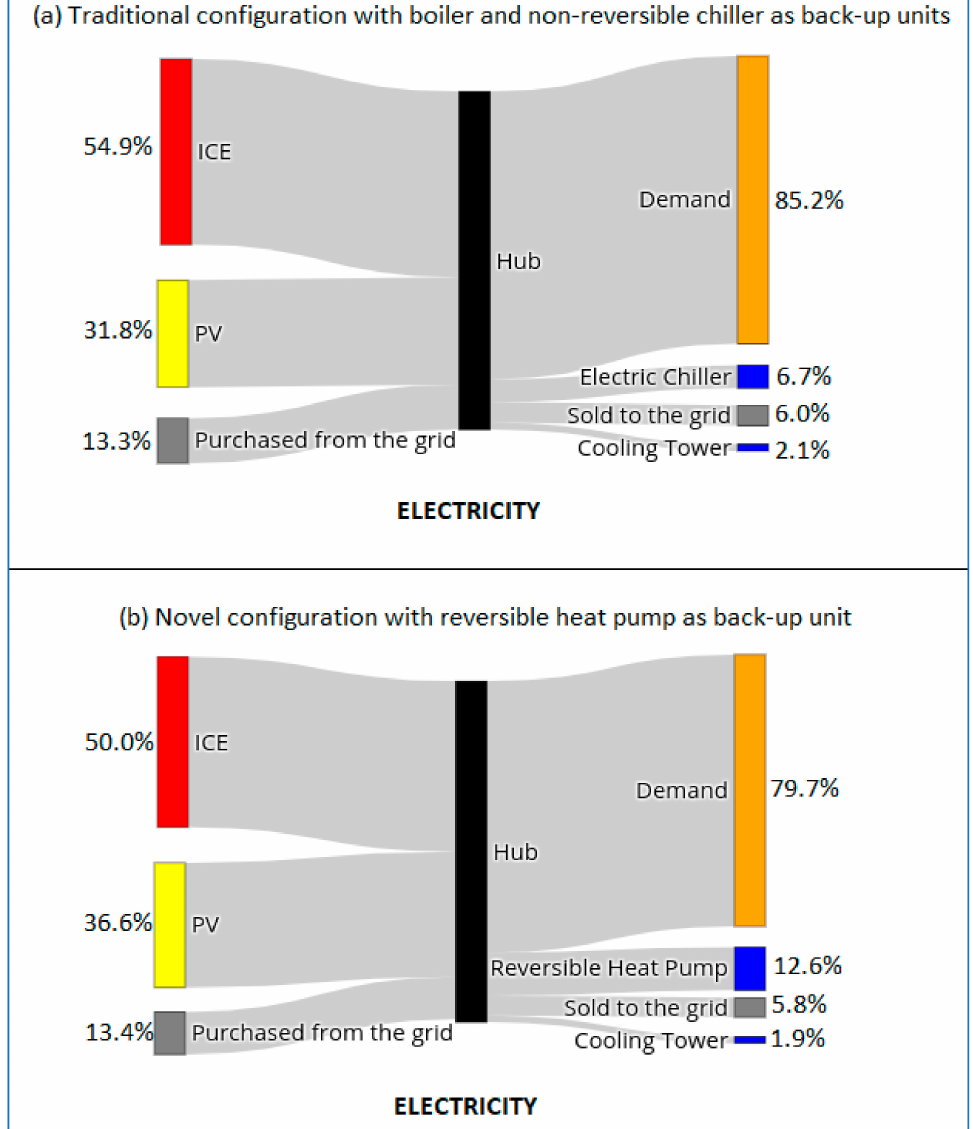
Figure 6. Sankey diagrams of the annual electricity balance for ( a ) traditional and ( b ) novel